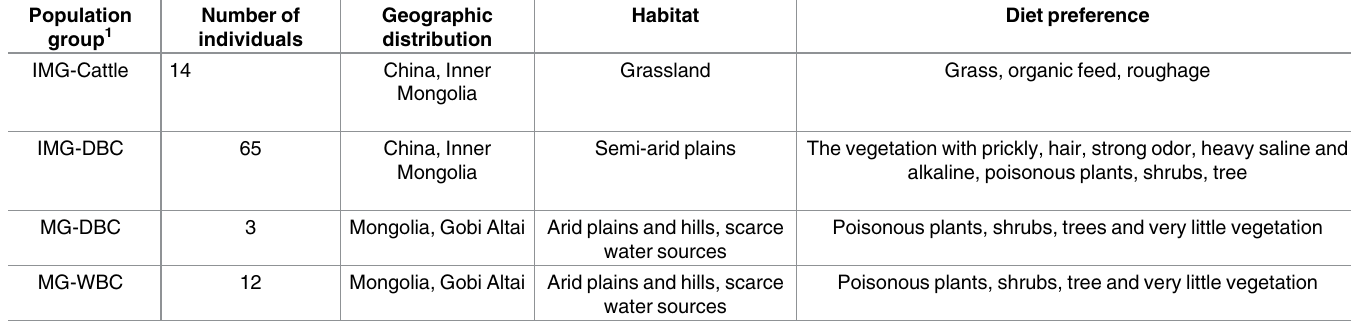
Table 1. Detailed characteristics of four population groups in this